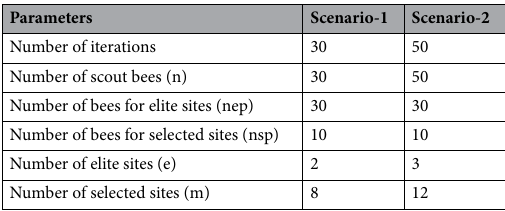
Table 2. Parameters of BA.